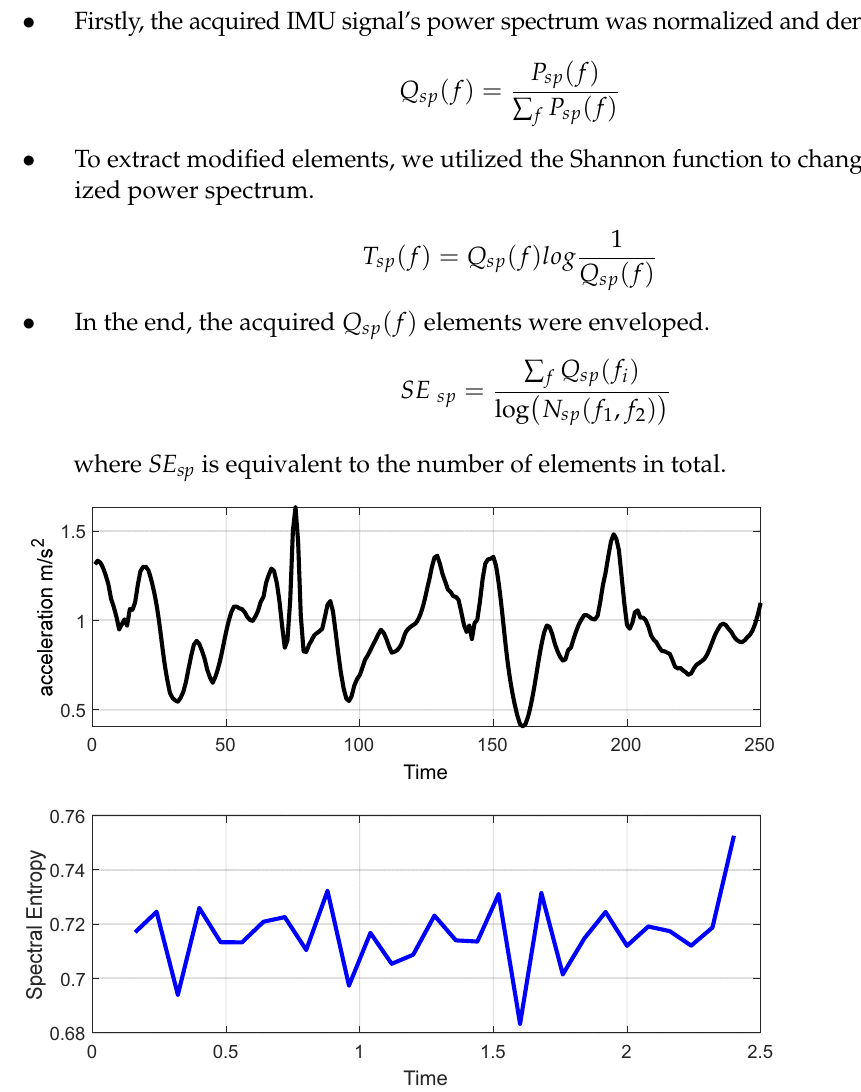
Figure 6. Spectral entropy for the upstairs walking activity signal plot from the MOTIONSENSE dataset. The black signal denotes inertial data and the blue signal represents the spectral entropy of an inertial signal from the MOTIONSENSE dataset.